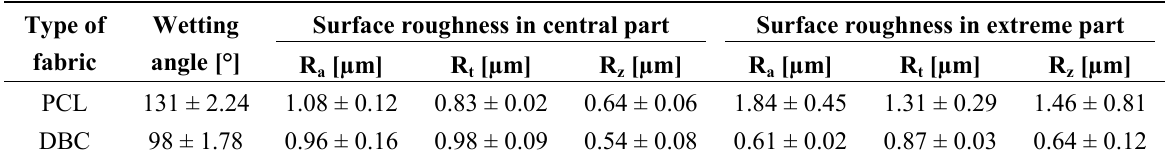
Table 4. Physicochemical properties of submicron nonwoven fabrics obtained by electrospinning. Type of Wetting Surface roughness in central part fabric angle [°]